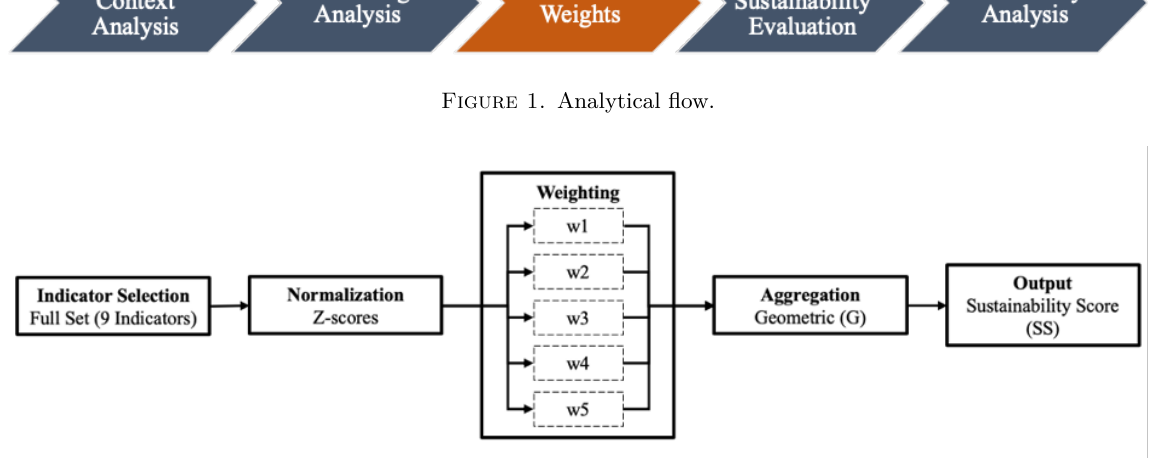
Figure 2. Sustainability evaluation framework using MCA.